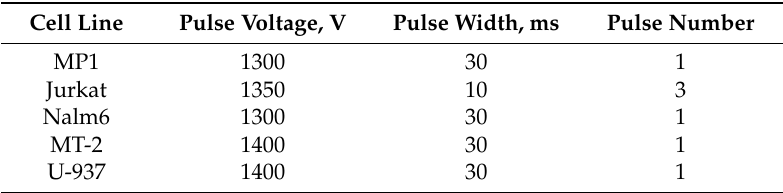
Table 4. Electroporation parameters used for